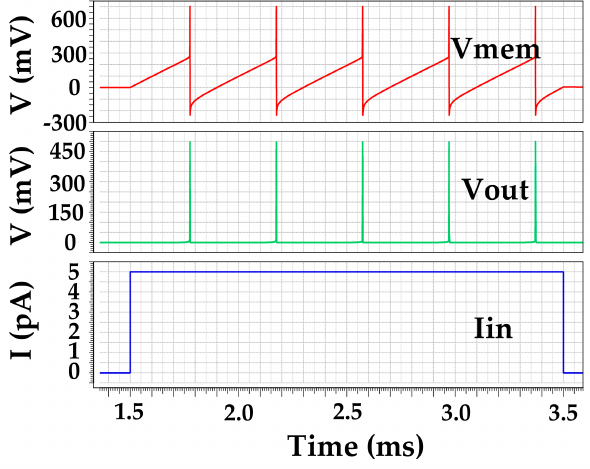
Figure 12. The transient simulation results of neural circuits. I in is the input current generated by the photodiode. V out is the output of the artificial neuron. V mem is the voltage of the membrane capacitor.